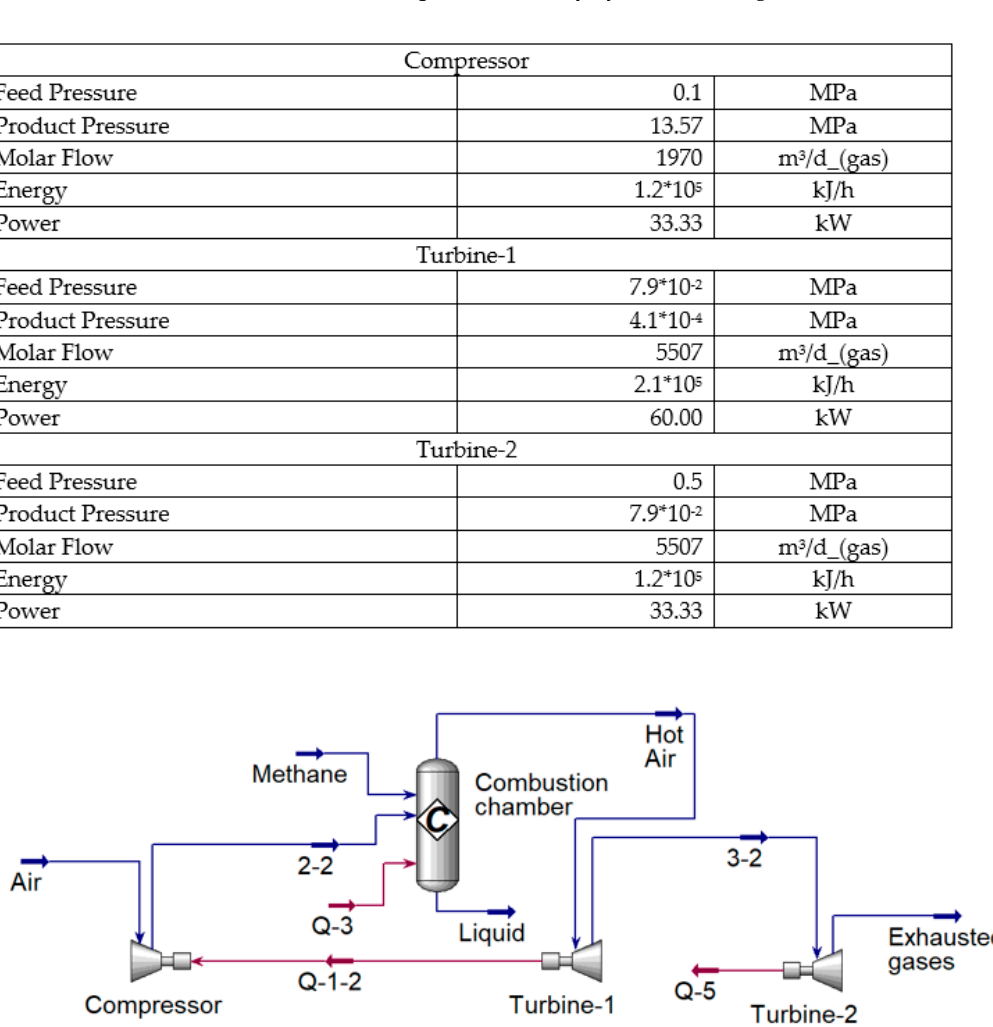
Figure 5. Simulation model for the first part of a binary system with a gas turbine.